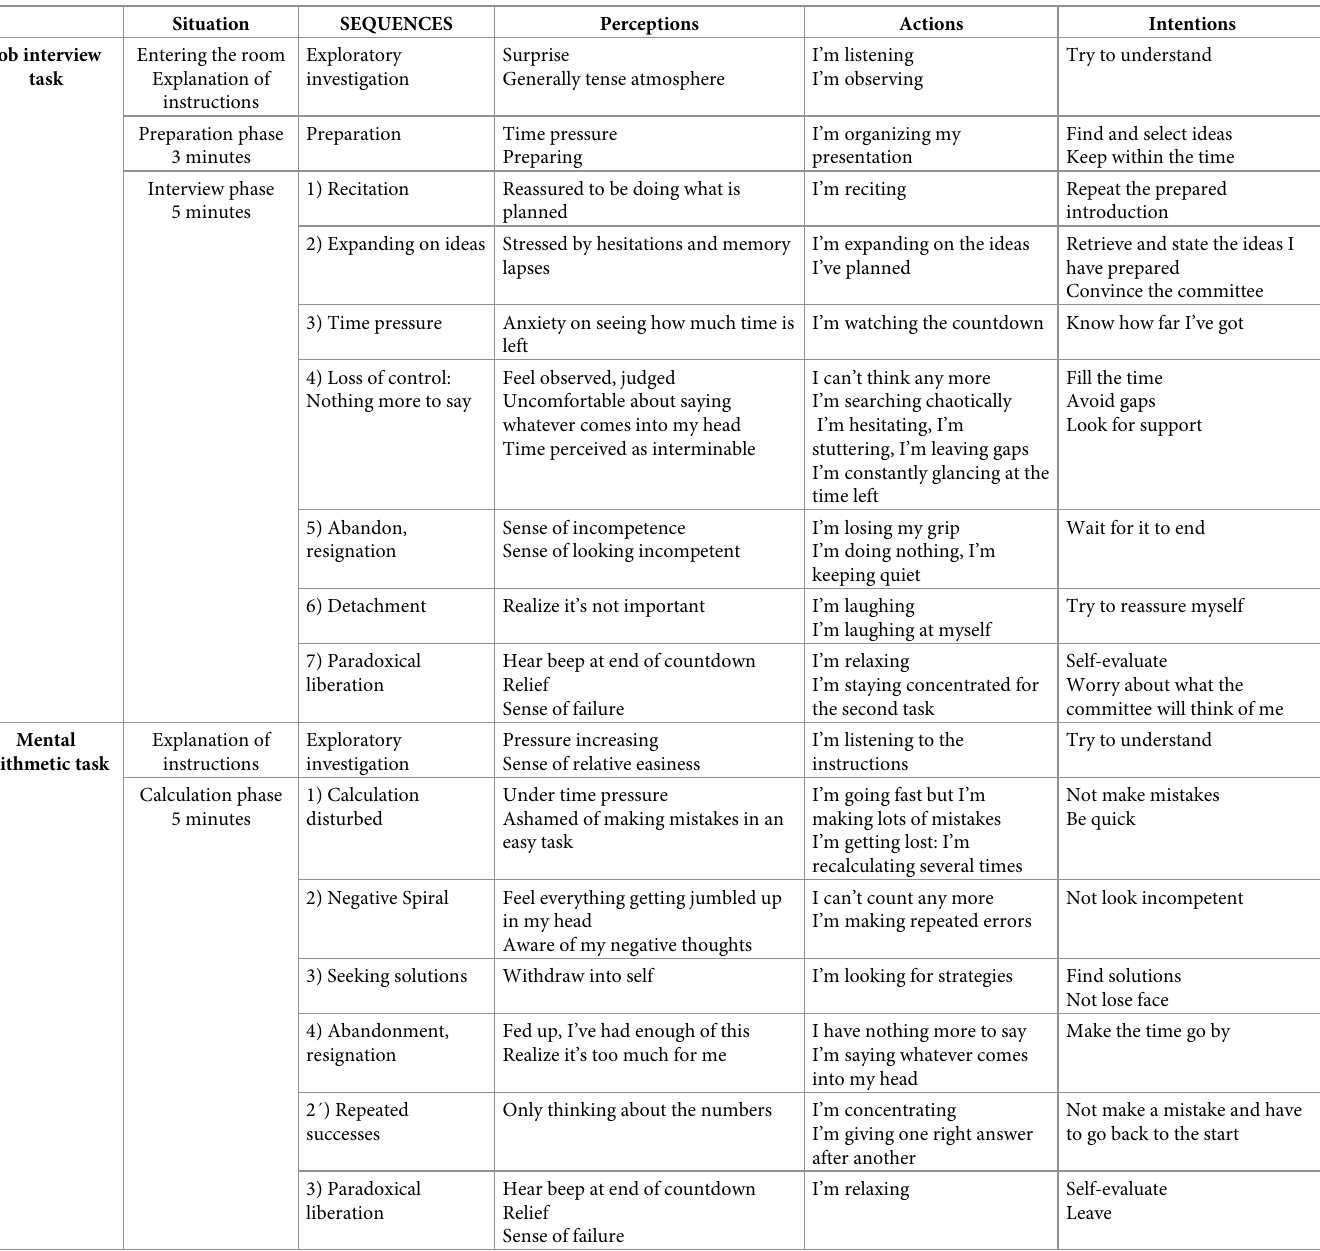
Table 3. Typical experience of the nine participants of the